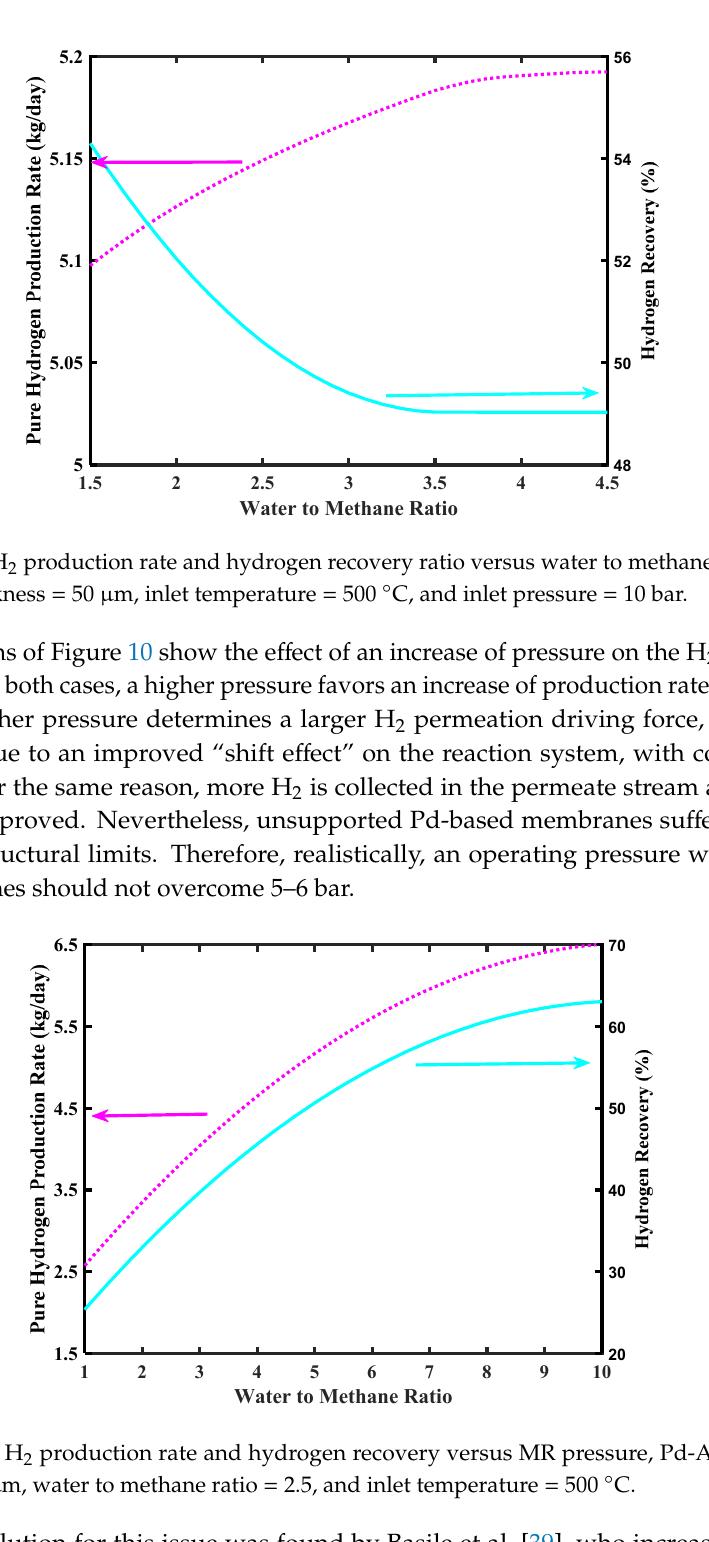
12 of 17 Figure 8. CO 2 and pure H 2 productions versus CH 4 consumption for Pd-Ag membrane thickness = 50 µm and water to methane ratio= 2.5, inlet temperature = 500 °C, and inlet pressure = 10 bar. 5.2. The Processor Flexibility Figure 9 shows the effect of feed ratio on pure H 2 production rate. As shown in the simulation, the H 2 production increases as the steam to CH 4 mole ratio increases, even though values higher than